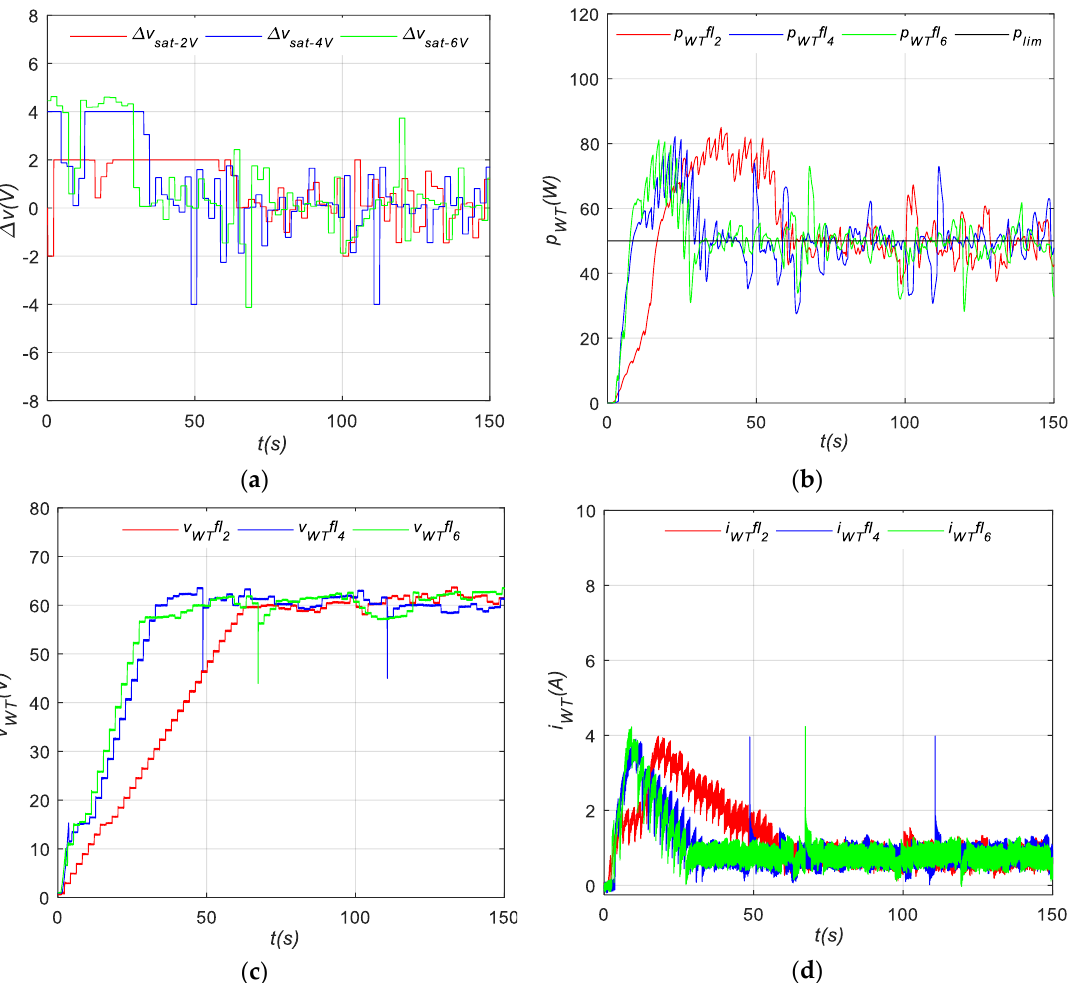
Figure 13. FL variable step-size P&O for LPP1: ( a ) evolution of ∆ v ; ( b ) evolution of p WT ; ( c ) evolution of v WT ; ( d ) evolution of i WT .